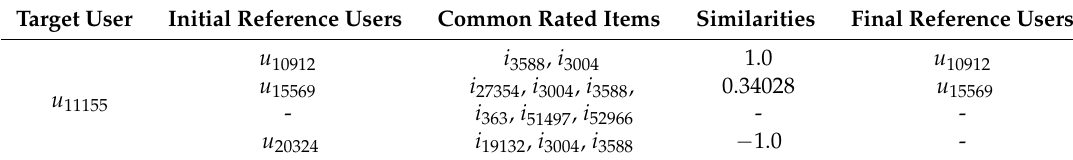
Table 2. Determining reference users of the target user u 11155 .